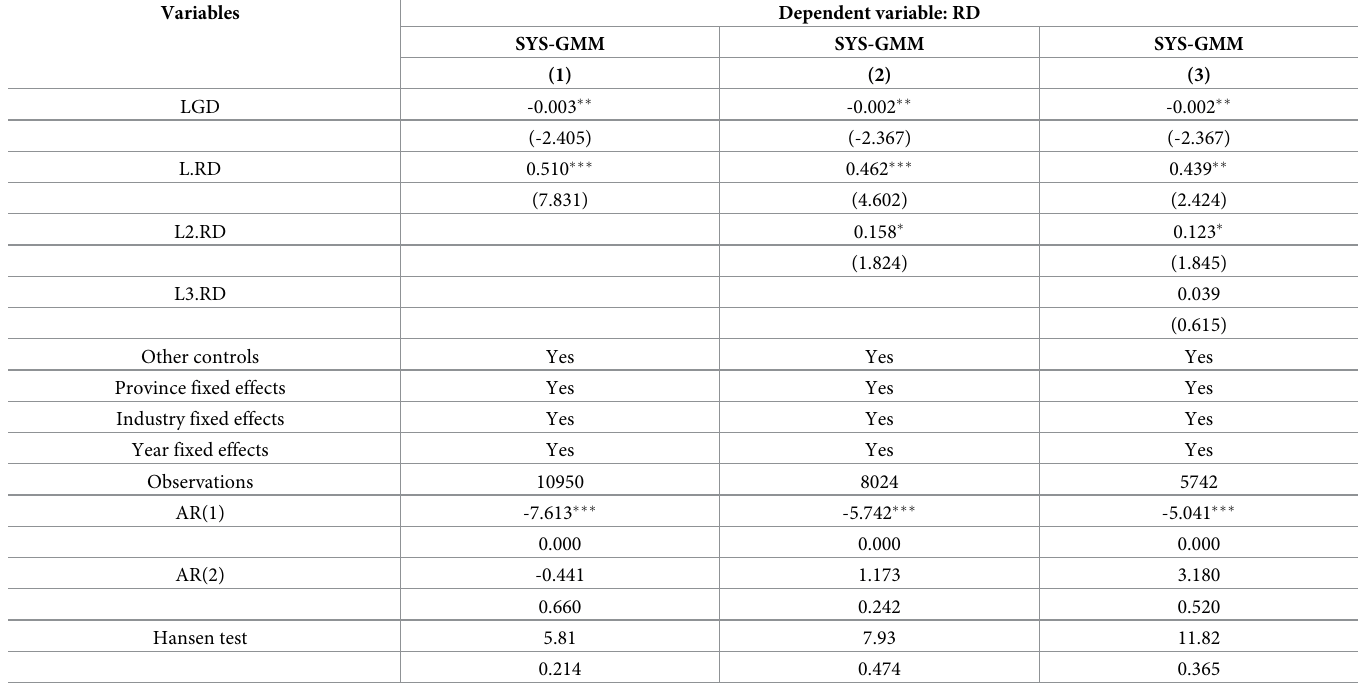
Table 9. The estimation results of the system